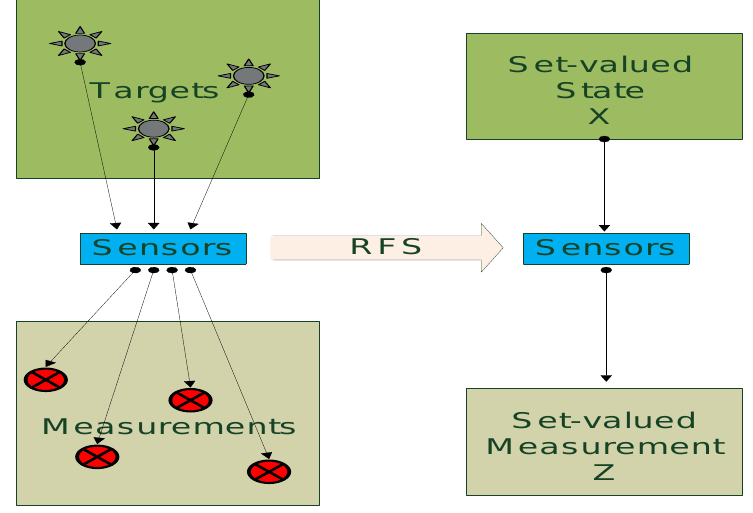
Figure 4. Set-valued states and set-valued